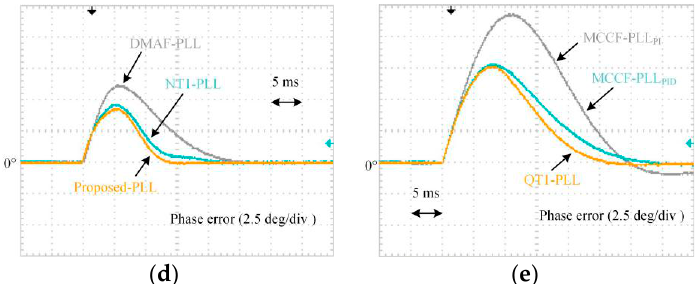
Figure 22. Experimental waveforms under a +5 Hz frequency step change: ( a ) Three-phase voltages; ( b , c ) Estimated frequency; ( d , e ) Phase error.